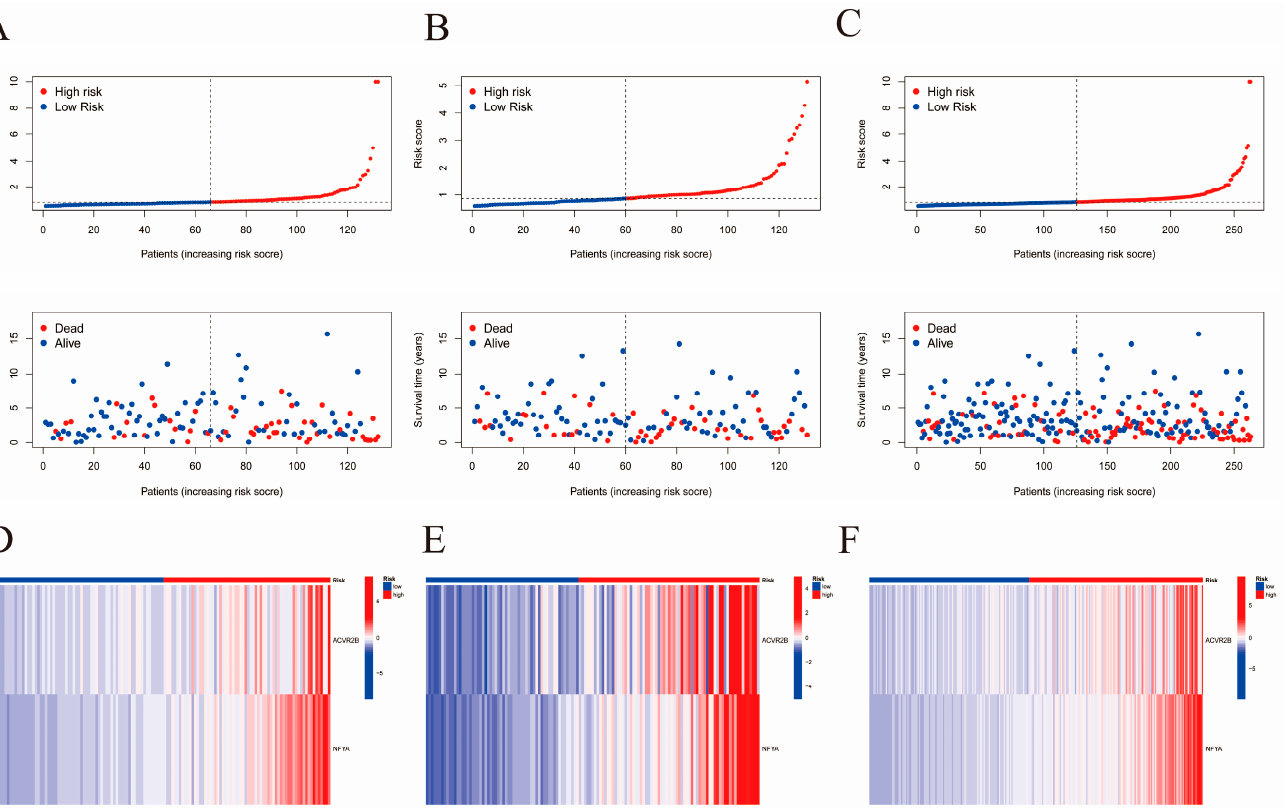
Figure 8. Analysis of correlation between high- and low-risk scores with survival and candidate gene expression. ( A – C ) Correlation between risk score and survival rate, based on training, validation, and the initial merged cohort, respectively. ( D – F ) Expression level of the two selected genes in the high- and low-risk groups, respectively, based on training, validation, and the initial merged cohort.